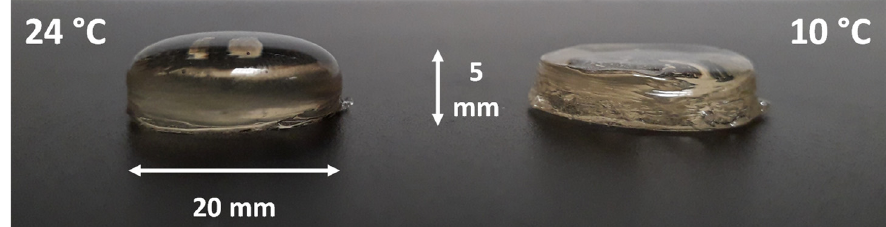
Figure 6. Effect of printing plate temperature on the cylinder geometry of protein gels.